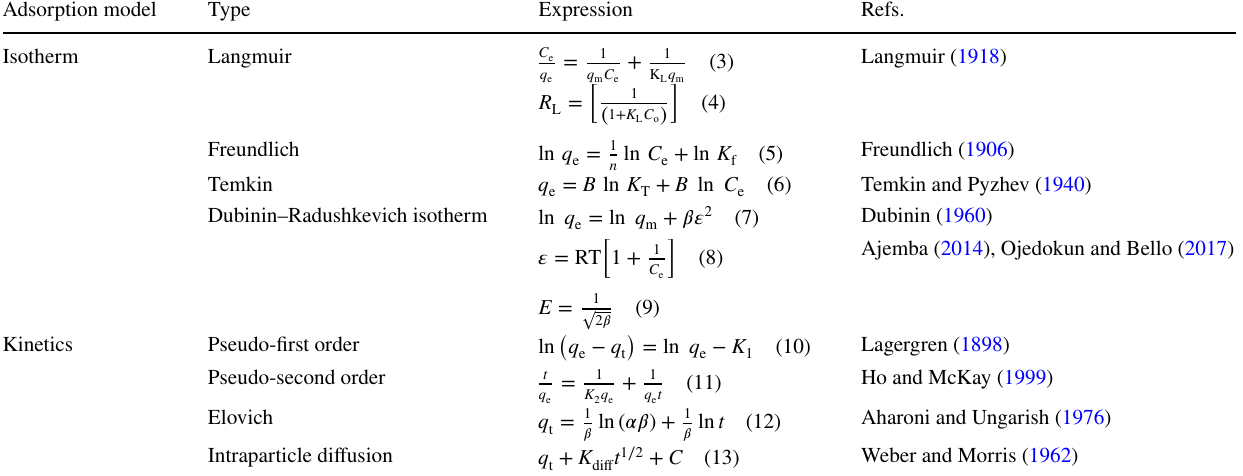
Table 1 Adsorption Isotherm and Kinetic Equations Adsorption model Type Expression